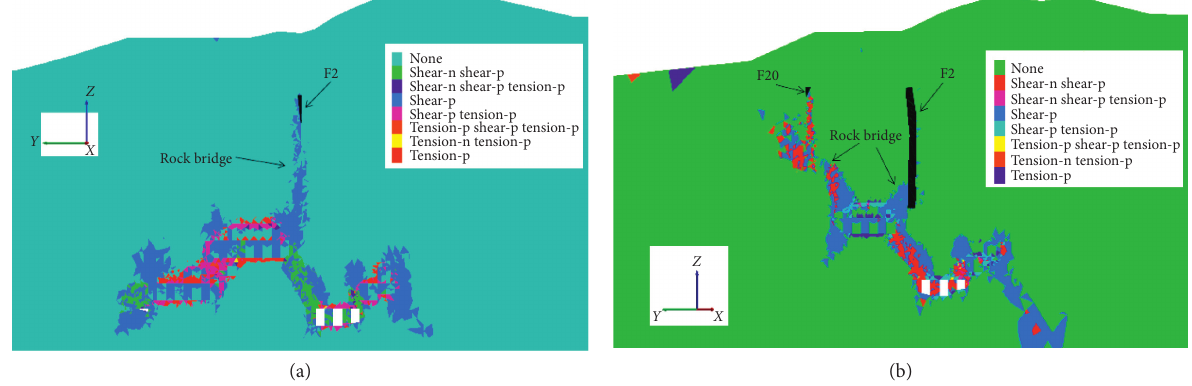
Figure 11: Plastic zone distribution diagram of model section. (a) Section 1. (b) Section 2.